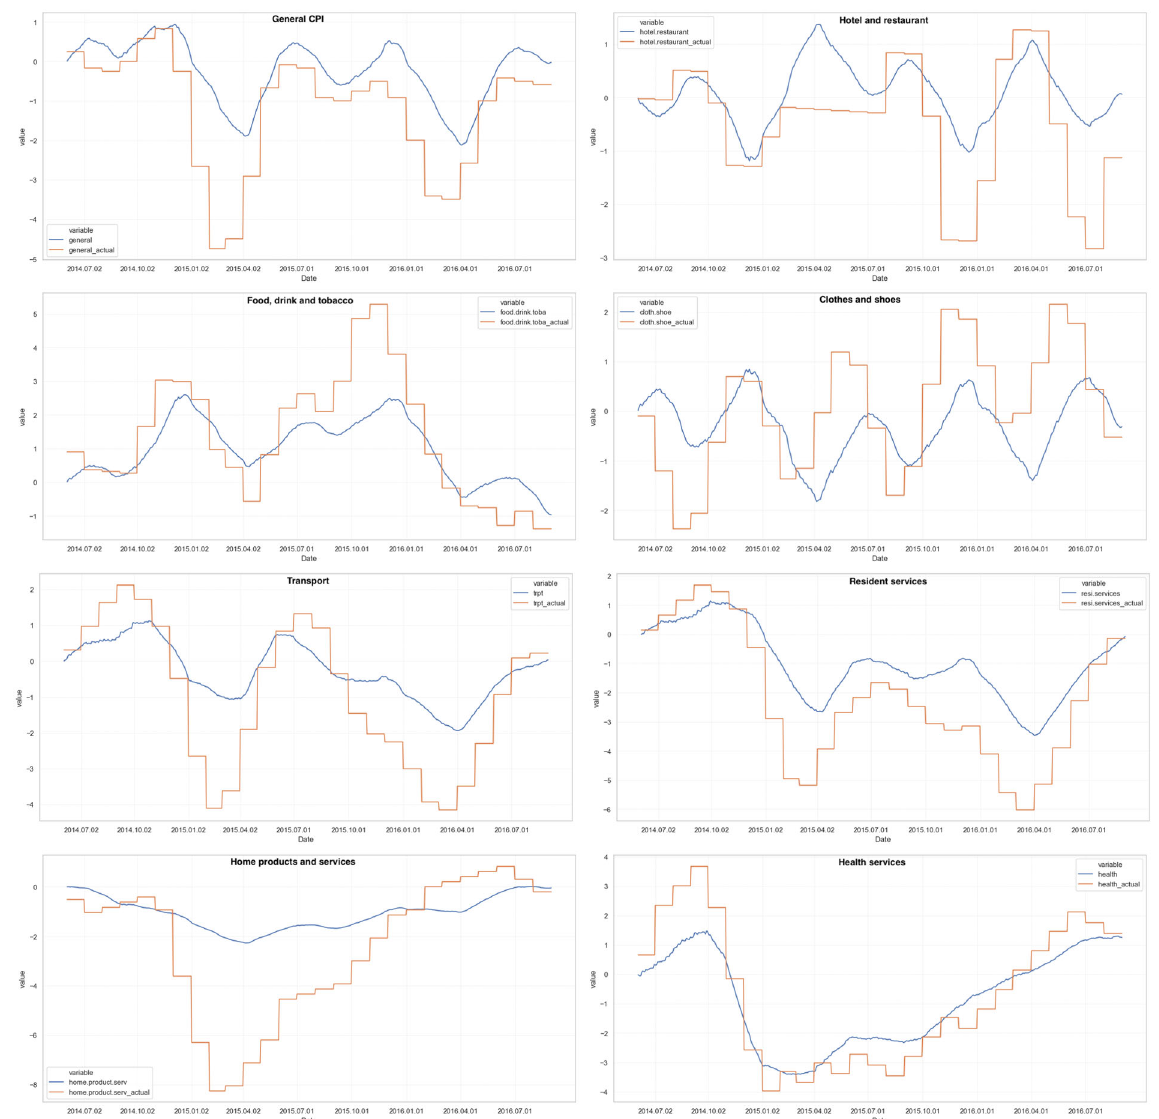
Fig. 7 Daily CPI nowcasting. The x -axis corresponds to the days. The y -axis is the predicted CPI (in blue) and the actual CPI (in orange), relative to the start of the period (June 1,